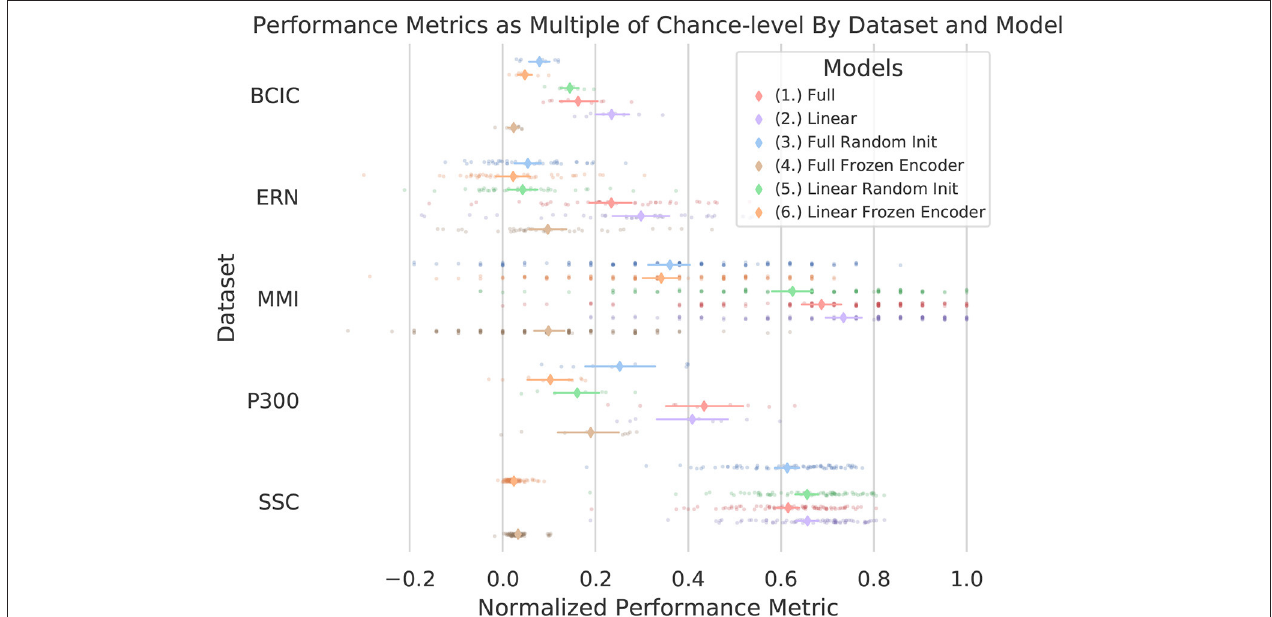
FIGURE 5 | Performance of all downstream datasets for each of the six model configurations considered. Metrics vary by dataset, see Table 2 . Metrics were normalized to range from chance (0) to perfect (1). Individual translucent points are performances of single subjects (within each test fold), solid diamonds indicate mean performance across all subjects/folds, with surrounding bars showing 0.95 confidence intervals using n = 1000 bootstrap sampling. The discretized pattern of the MMI dataset is due to the limited trials per subject , which resulted in limited distribution of performance levels. Notably here, (1) or (2) was consistently among the best performing, yet both remained within the confidence levels of each other and aside from a few cases with the ERN dataset did not result in subject performances that were worse than chance. (3) and especially (4) and (6) often stayed marginally above chance, indicating that the pre-trained features were not sufficient without further training. The randomly initialized average-pooled BENDR with linear classifier (5) also performed well, though less consistently, suggesting pre-training was needed for consistent performance. Model configurations are numbered in accordance with the list presented in section